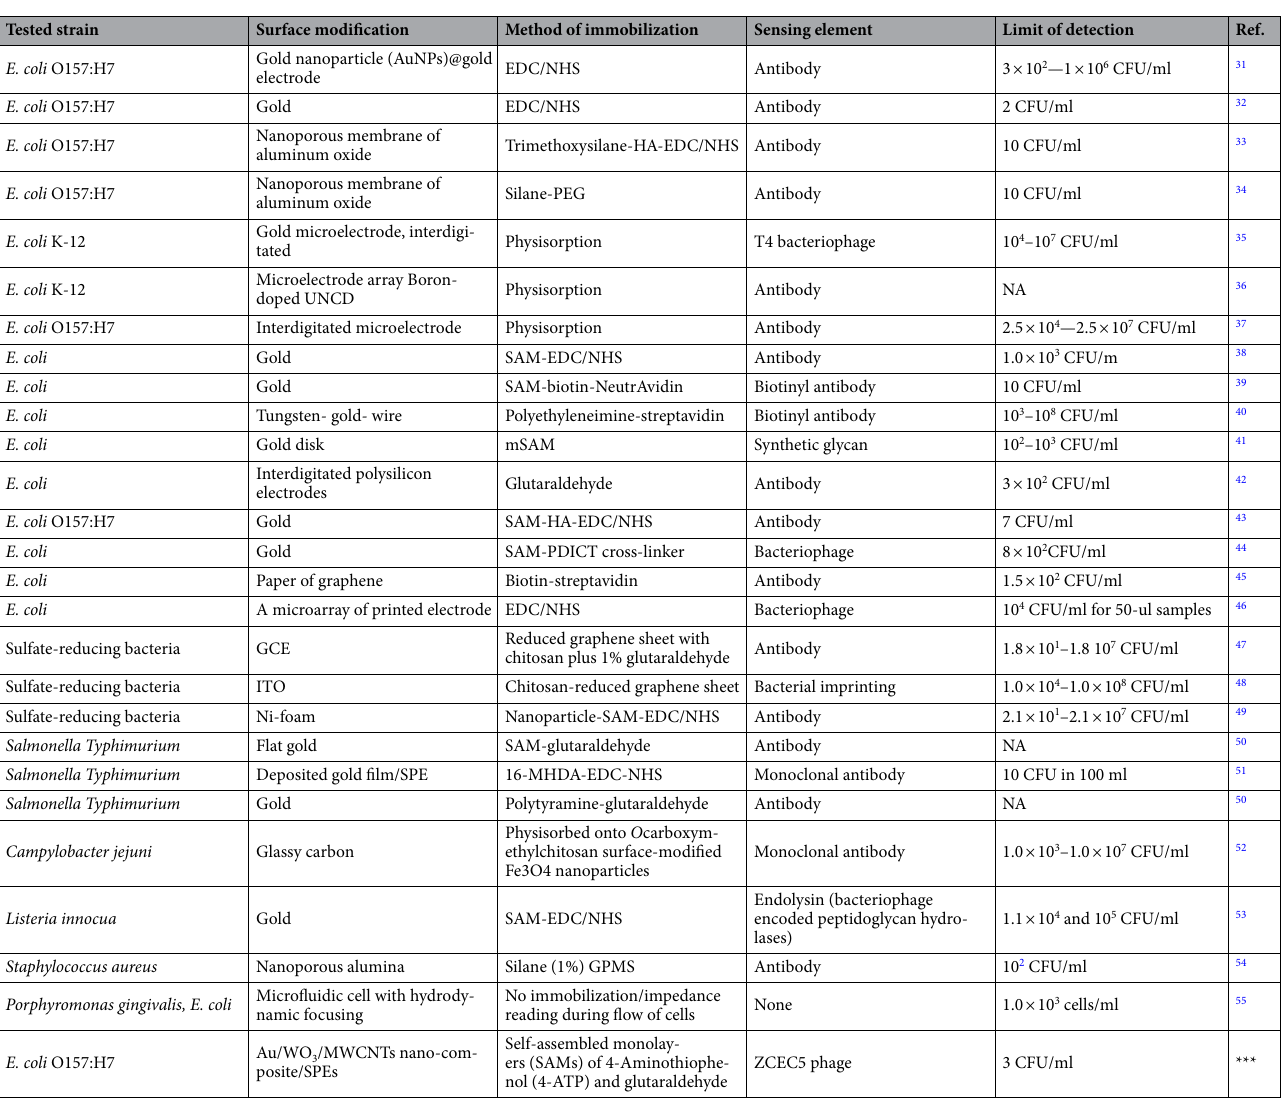
Table 1. A collection of the previously reported impedimetric bacterial detections using different types of biorecognition elements and different types of nanomaterials for surface modification. (***) is the newly developed phage